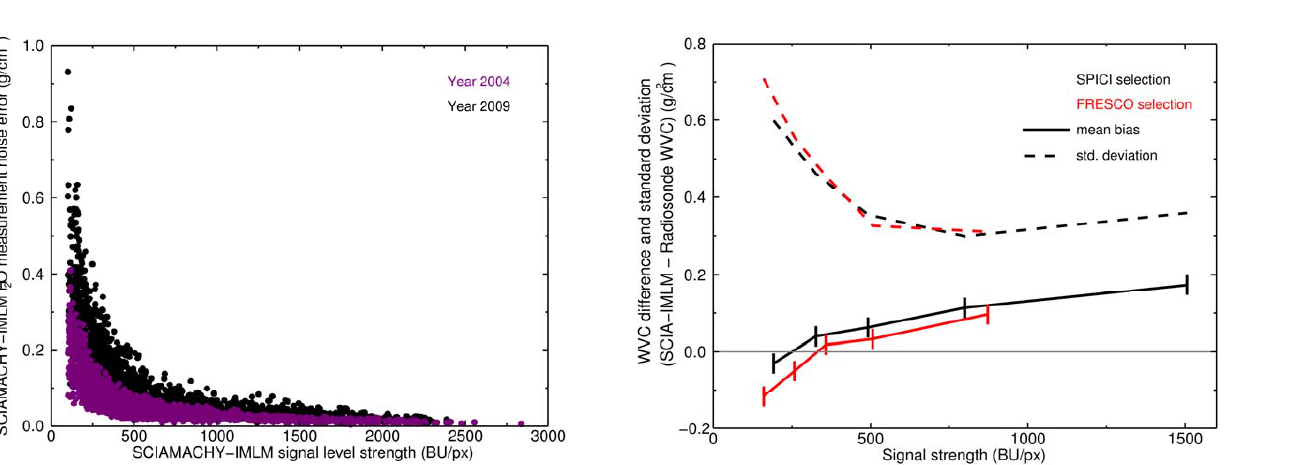
Fig. 12. SCIAMACHY-IMLM WVC measurement noise error as a Fig. 13. The mean difference (solid line) and the standard deviation Figure 13. The mean difference (straight line) and standard deviation (dashed line) between function of the signal strength for two years of 2004 and 2009 (note (dashed line) between SCIAMACHY-IMLM and radiosonde WVC Figure 12. SCIAMACHY-IMLM WVC measurement noise error as a function of the signal that in the figure some values in purple overlap those in black). The amounts as a function of the SCIAMACHY-IMLM signal strength. SCIAMACHY-IMLM and radiosonde WVC amounts as a function of the SCIAMACHY- strength for two years of 2004 and 2009 (note that in the figure some values in purple overlap data used in this figure are for cloud-free measurement cases with For the black lines the cloud-free condition is based on SPICI (700 IMLM signal strength. For the black lines the cloud-free condition is based on SPICI (700 the additional methane filter applied (see Sect. 2.2.2) and a signal collocations per bin), for the red lines on FRESCO + , requiring those in black). The data used in this figure are for cloud free measurement cases with the level strength above 100BUpx − 1 . a cloud fraction <0.02 (407 collocations per bin). SCIAMACHY- collocations per bin), for the red lines on FRESCO+, requiring a cloud fraction < 0.02 (407 additional methane-filter applied (see Sect. 2.2.2) and a signal level strength above 100 BU/px. IMLM cases included in this selection are for both land and collocations per bin). SCIAMACHY-IMLM cases included in this selection are for both land ocean measurements, excluding cases with signal strength below and ocean measurements, excluding cases with signal strength below 100 BU/px. 100BUpx − 1